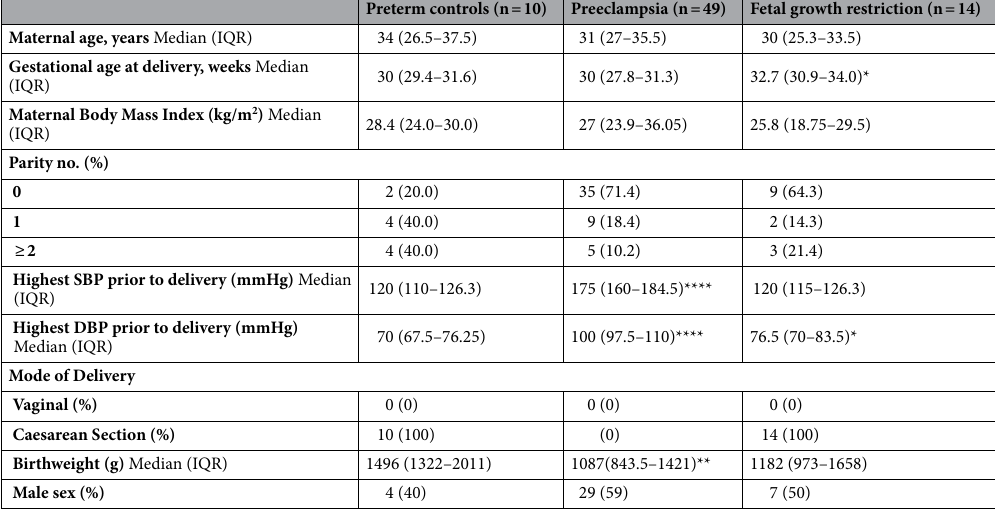
Table 3. Patient characteristics of cases with preeclampsia, fetal growth restriction and control samples for gene (mRNA) expression studies. BMI data unavailable for n = 3 preterm controls, n = 1 fetal growth restriction samples. Birthweight data unavailable for n = 1 preeclamptic sample. Statistical analysis compared the preeclamptic or fetal growth restricted samples to the preterm controls. * p < 0.05, ** p < 0.01, **** p <